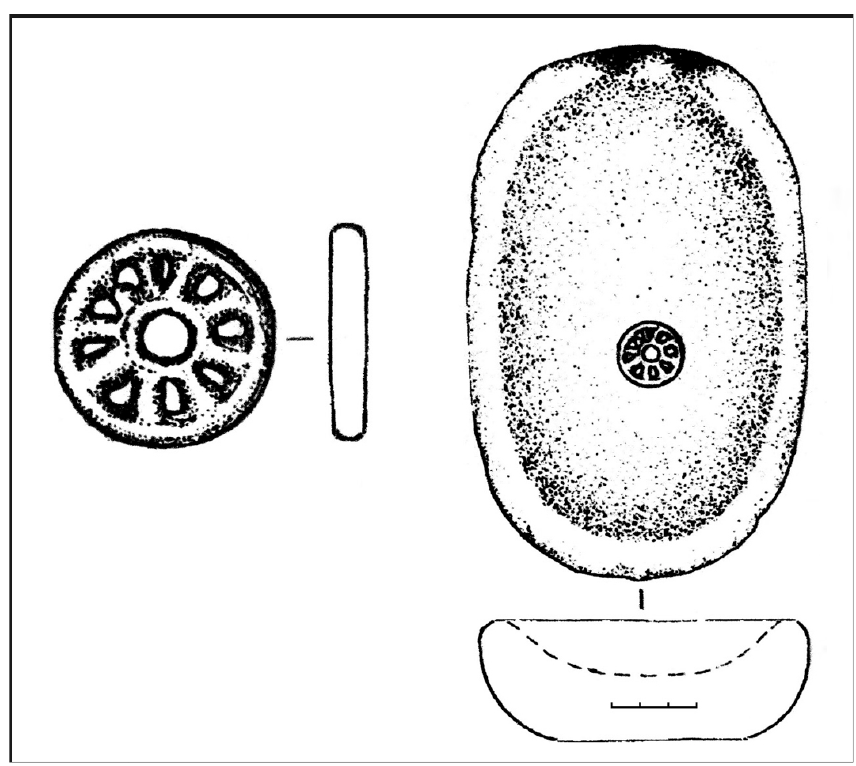
Figure 12. A bronze wheel found inside a stone altar (Umansky et al. 2005; pp. 8–10—after P.I. Shulga